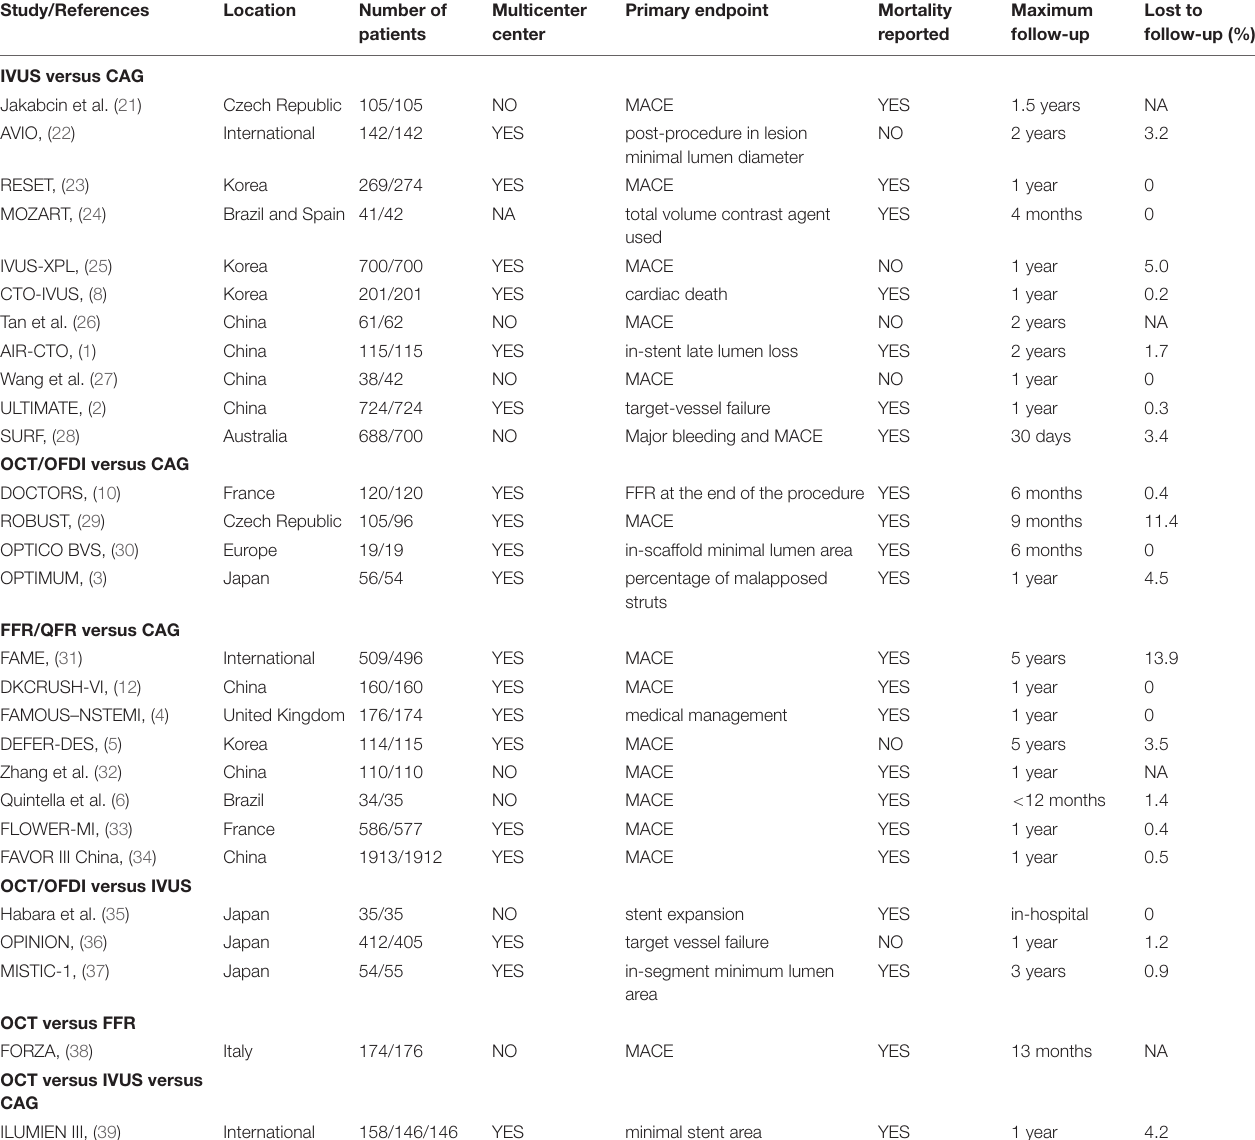
TABLE 1 | Baseline characteristics of included randomized